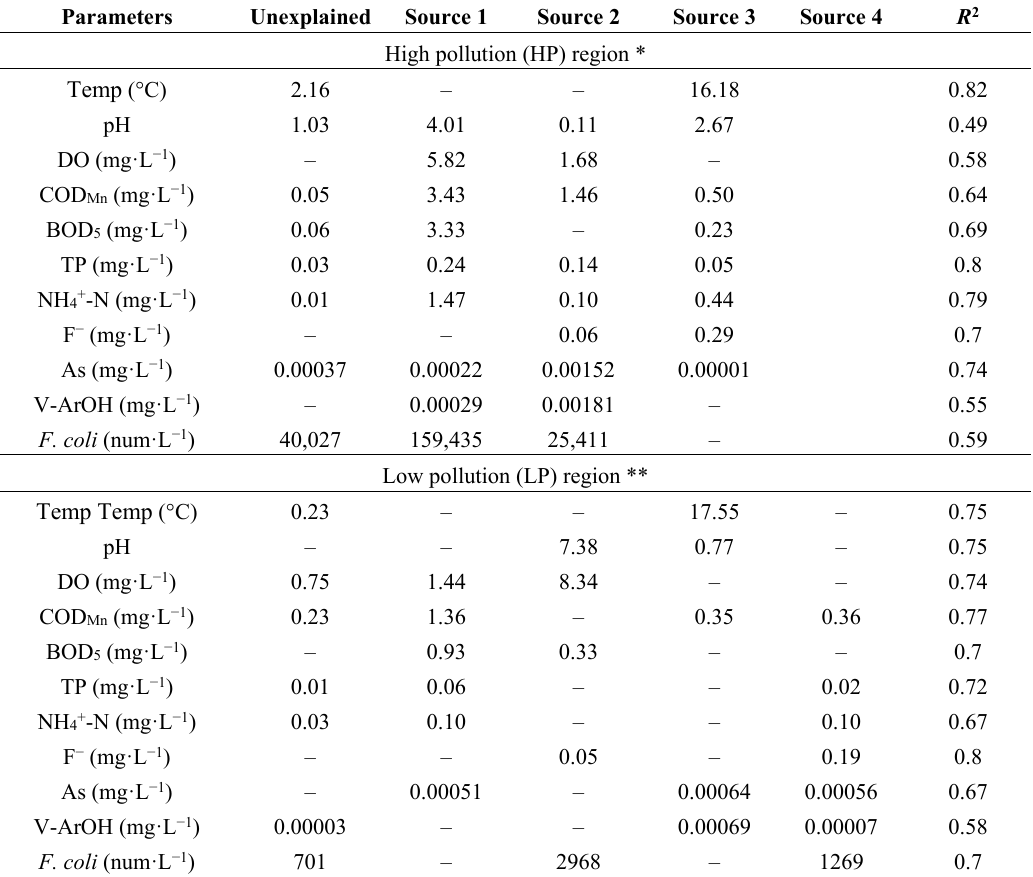
Table 9. Results of the APCS-MLR method in high pollution (HP) region and low pollution (LP)